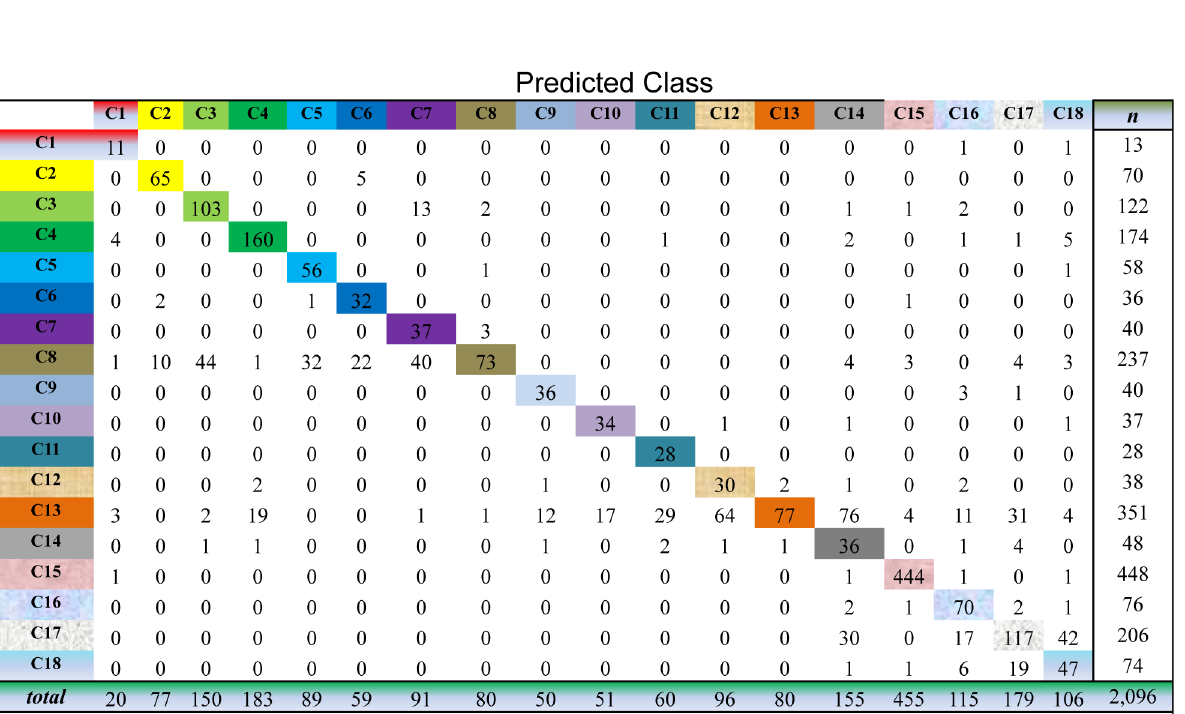
Fig 9. Confusion matrix of prediction results using Semi-PNMF, which achieves a total accuracy of 73.43%. Matrix delineates distribution of actual compared with predicted class membership for multiclass cancer prediction on the Acute Leukemia dataset.